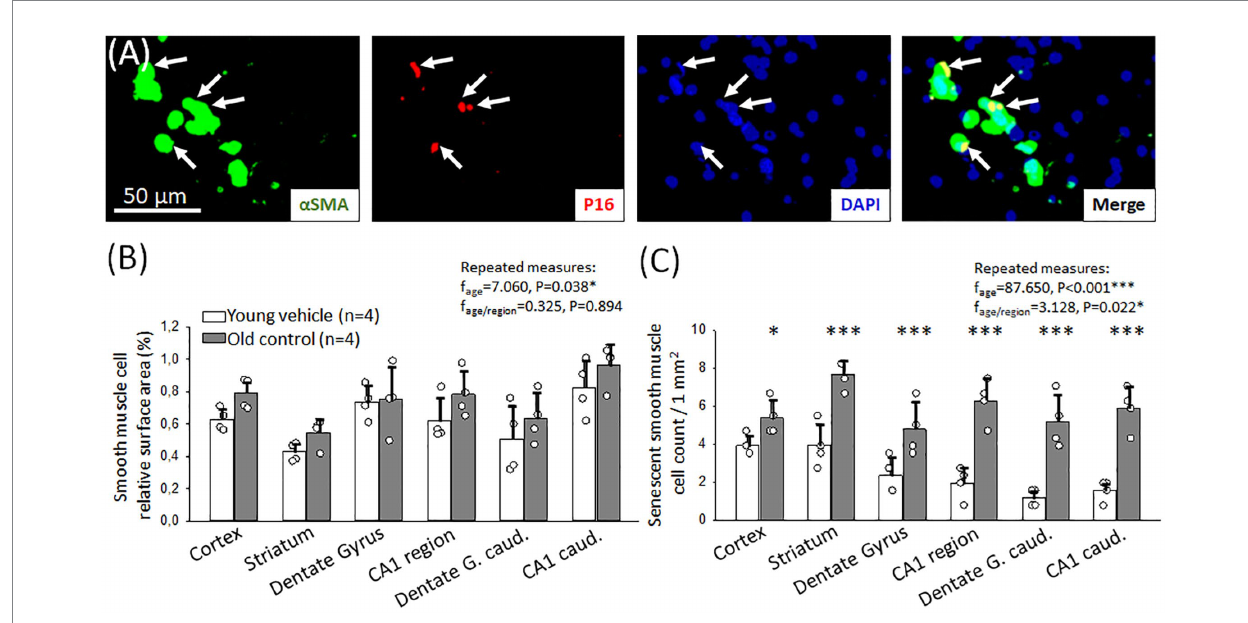
FIGURE 4 Immunocytochemical characterization of cerebrovascular smooth muscle cell (cerebrovascular SMC) senescence. (A) Representative fluorescence micrographs of α SMA and p16 co-localization (arrows) in the hippocampal CA1 region of an old animal. α SMA corresponding to cerebrovascular SMC coverage is shown in green, p16 labeling indicating senescent cells is red; and DAPI illustrates the cell nuclei in blue. (B) Relative area covered by cerebrovascular SMC labeled with α SMA in different forebrain regions in young and old animals. (C) The number of senescent cerebrovascular SMCs in young and old animals in different brain regions. Individual data points represent the mean value of three sections in each animal. Bar charts show mean ± stdev. The normal distribution of data was evaluated with a Shapiro–Wilk test ( B : p = 0.488, C : p = 0.709). For further statistical analysis, a repeated measures model was used (RM ANOVA), followed by a Holm Sidak post hoc test. Levels of significance were set as p < 0.05*, p < 0.01**, p < 0.001*** vs. Young